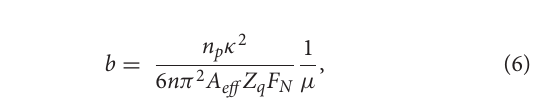
amplitude u o and tangential velocity amplitude v o = i ω u o